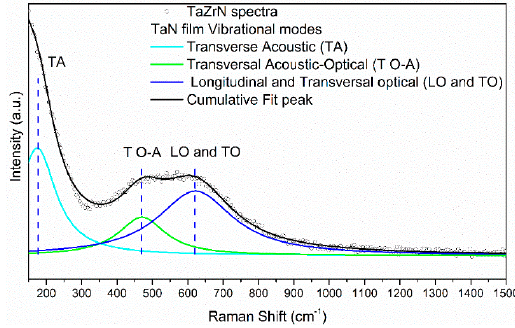
Figure 4. Raman spectra of as deposited TaZrN film.